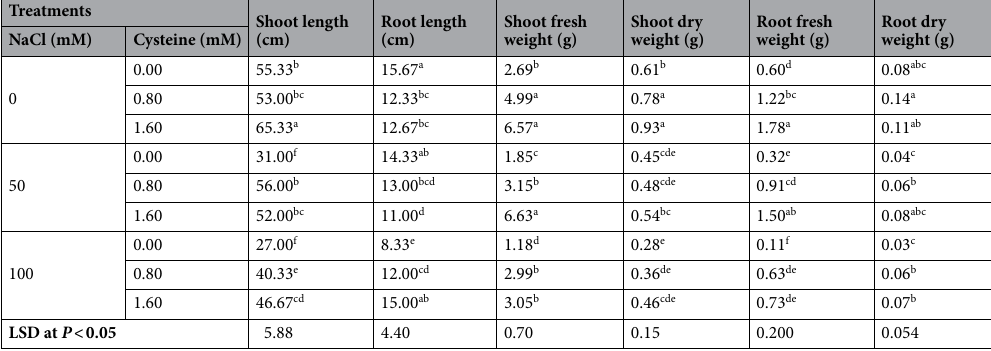
increased with increasing the concentration of salinity. The results showed that NaCl at 100 mM reduced shoot length, root length, and fresh and dry weights of shoot and root per plant by 51.20, 46.84, 56.13, 54.10, 81.67, and 62.50%, respectively, compared to the control values. On the other hand, foliar application of cysteine (0.8 and 1.6 mM) considerably increased the vegetative growth criteria of flax plants under normal conditions and saline irrigation. Under normal conditions, 1.6 mM cysteine improved the shoot length and fresh and dry weights of shoot and root by 18.07, 144.24, 52.46, 196.67, and 37.50% compared to the control plants (Table 1). The interaction between salinity at 50 mM and cysteine at 1.6 mM caused significant ( P < 0.05) increases; 67.74, 258.38, 20.0, 368.75, and 100% for shoot length, fresh and dry weights of shoot and root per plant, respectively, compared to the untreated salinized plants (Table 1). Moreover, cysteine at 1.6 mM improved shoot length, root length, shoot and root dry weights, and shoot and root fresh weights by 72.85, 80.1, 158.5, 64.3, 563.6, and 133.3%, respectively, in the 100 mM NaCl stressed plants.